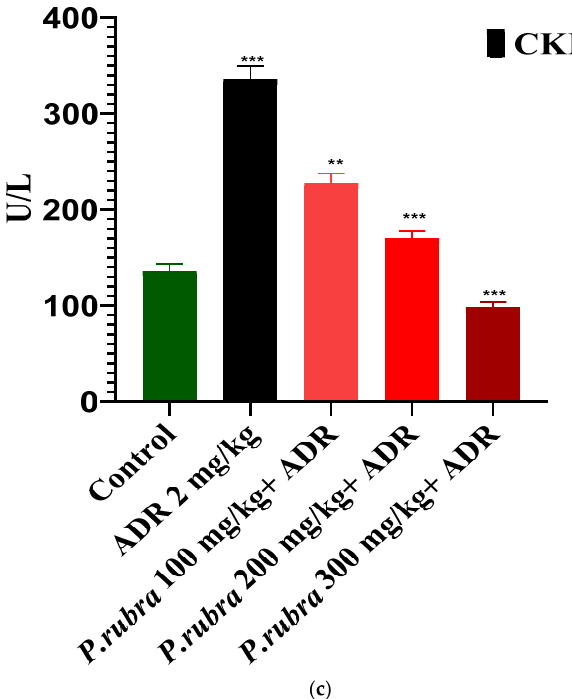
Figure 3. Cardioprotective effect of three doses of aqueous-methanolic leaf extract of P. rubra on the cardiac biomarkers, LDH ( a ), CK-MB ( b ), and troponin ( c ) against ADR-intoxicated MI. One-way ANOVA and Dunnett’s multiple comparison test were performed (** p < 0.005 & *** p < 0.001 & ns p > 0.005, n = 5).